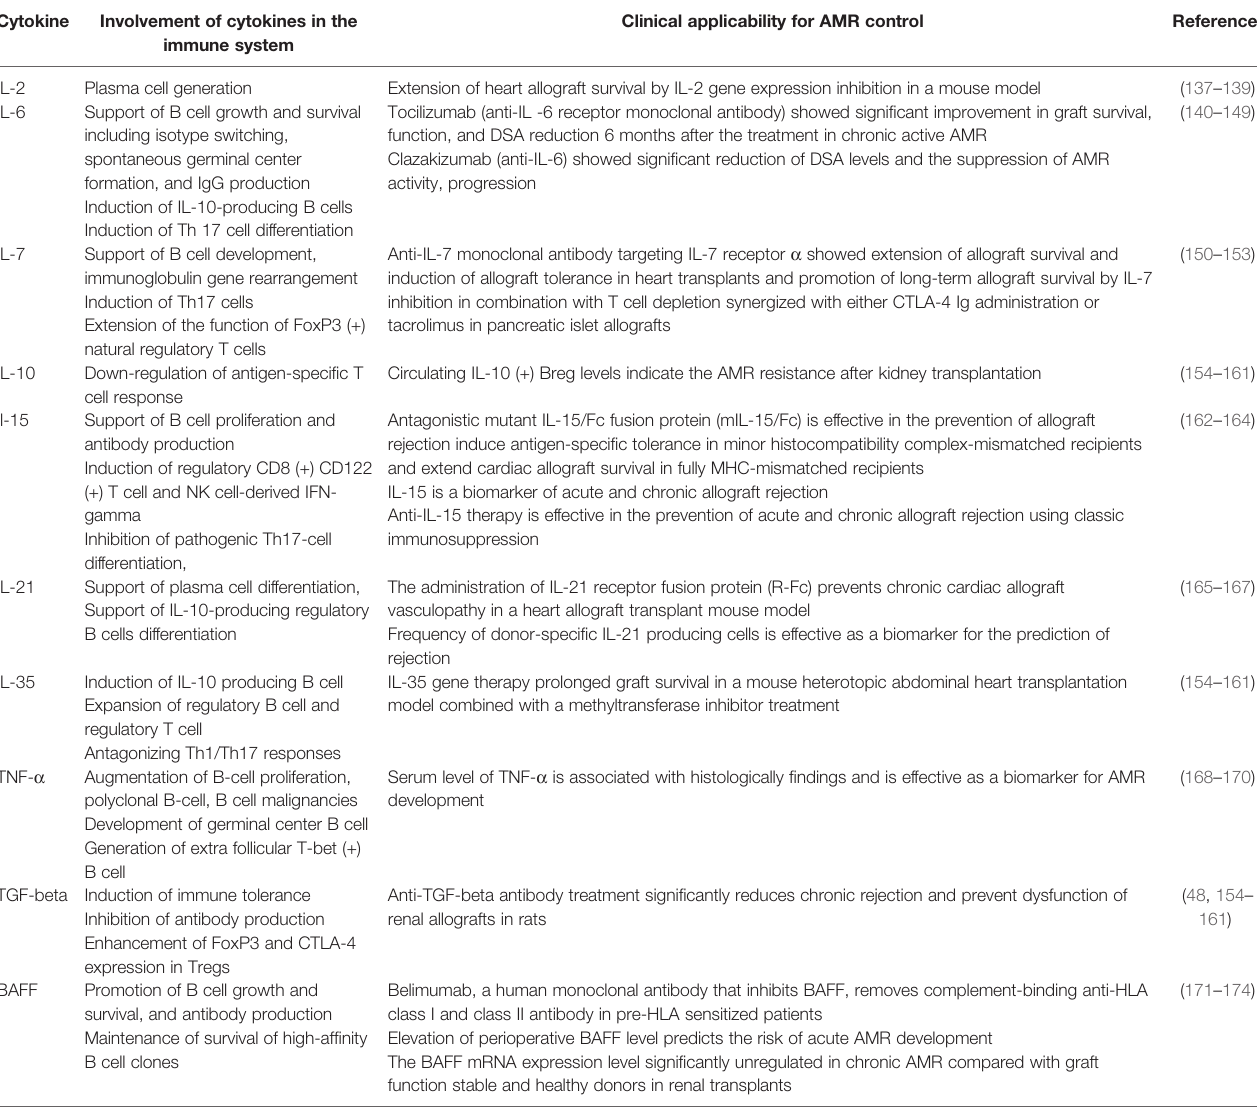
TABLE 2A | Involvement of cytokines in the immune system and clinical applicability for